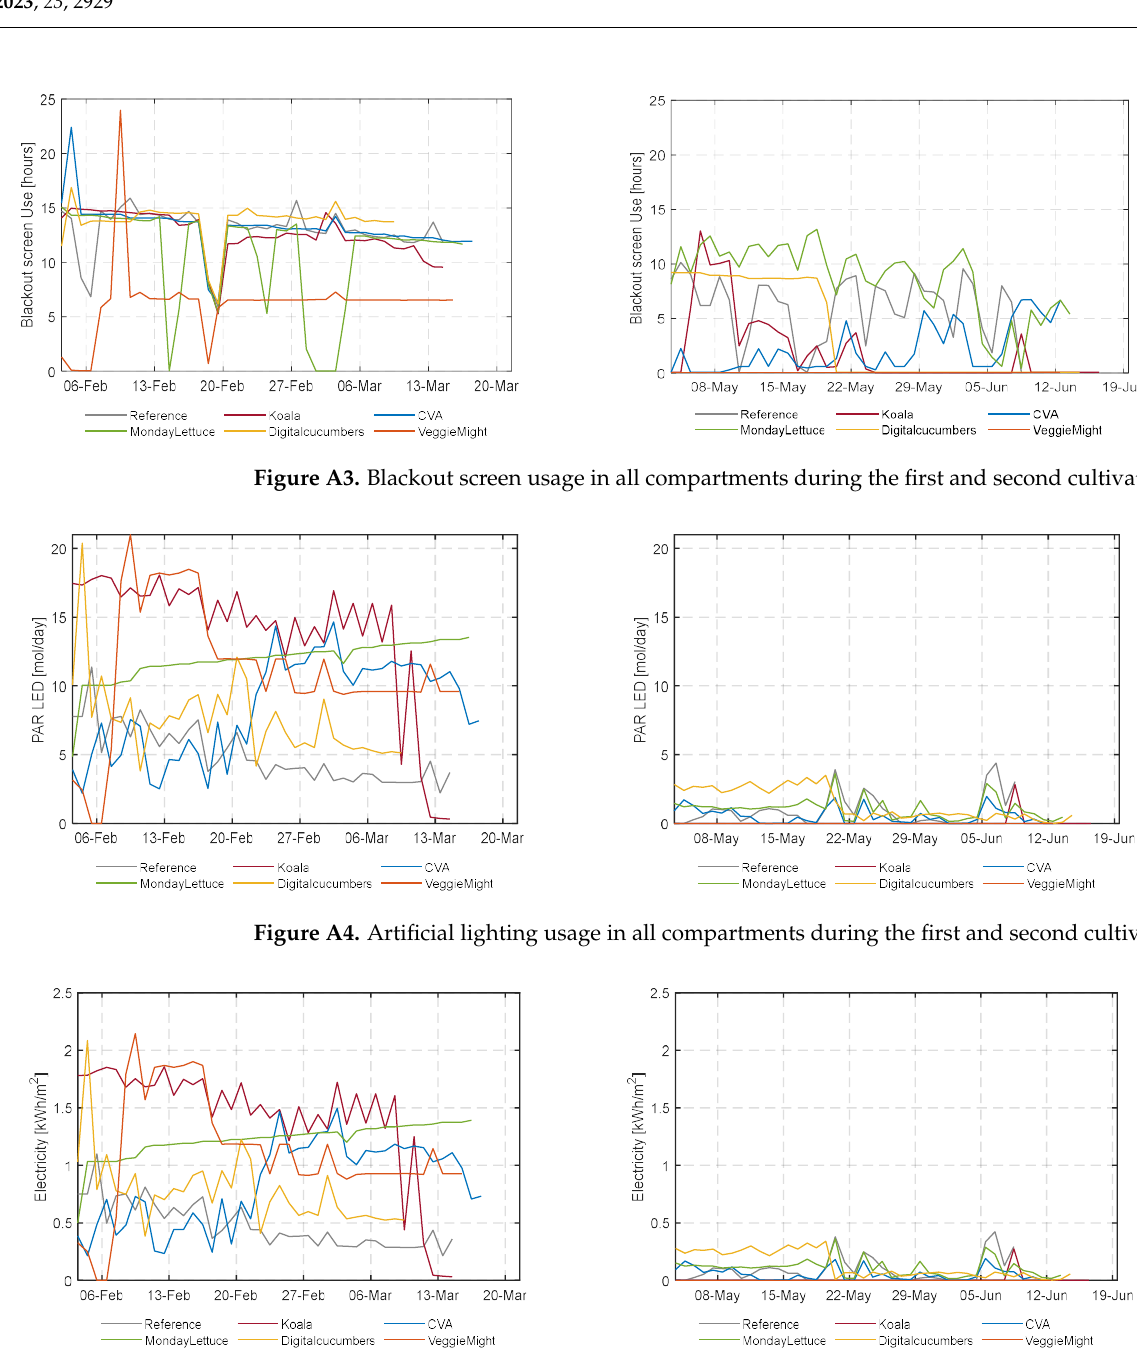
Figure A5. Electricity consumption (kWh/m 2 ) in all compartments during the first and second cultivation.